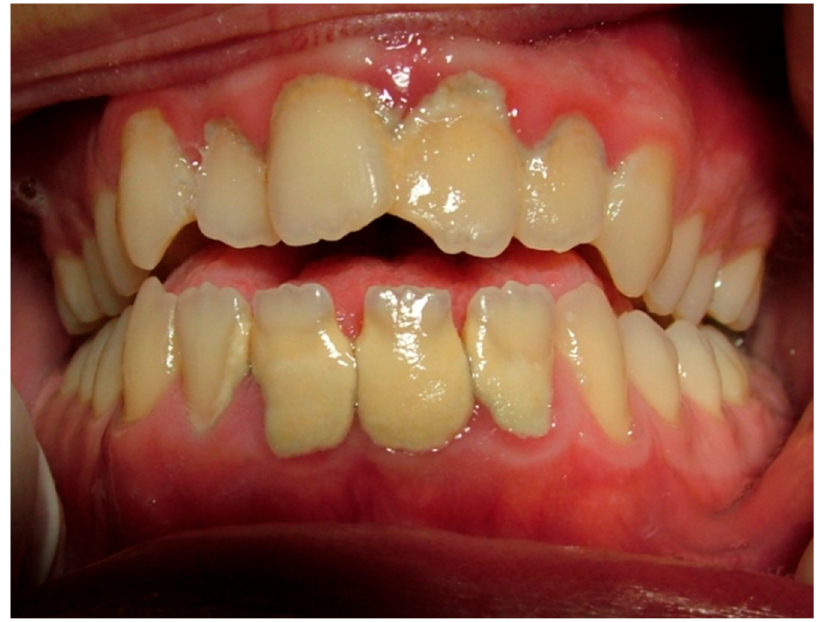
Figure 1. A case of a pregnant woman with periodontal disease due to poor oral health status.